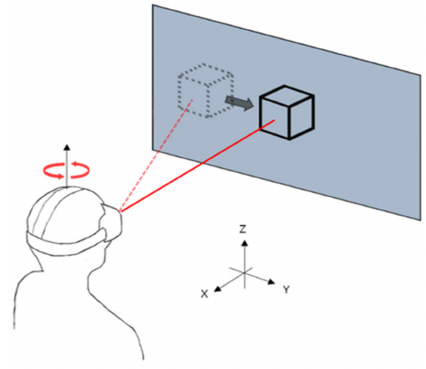
Figure 4. Example image of how to manipulate the position of a virtual object using Head